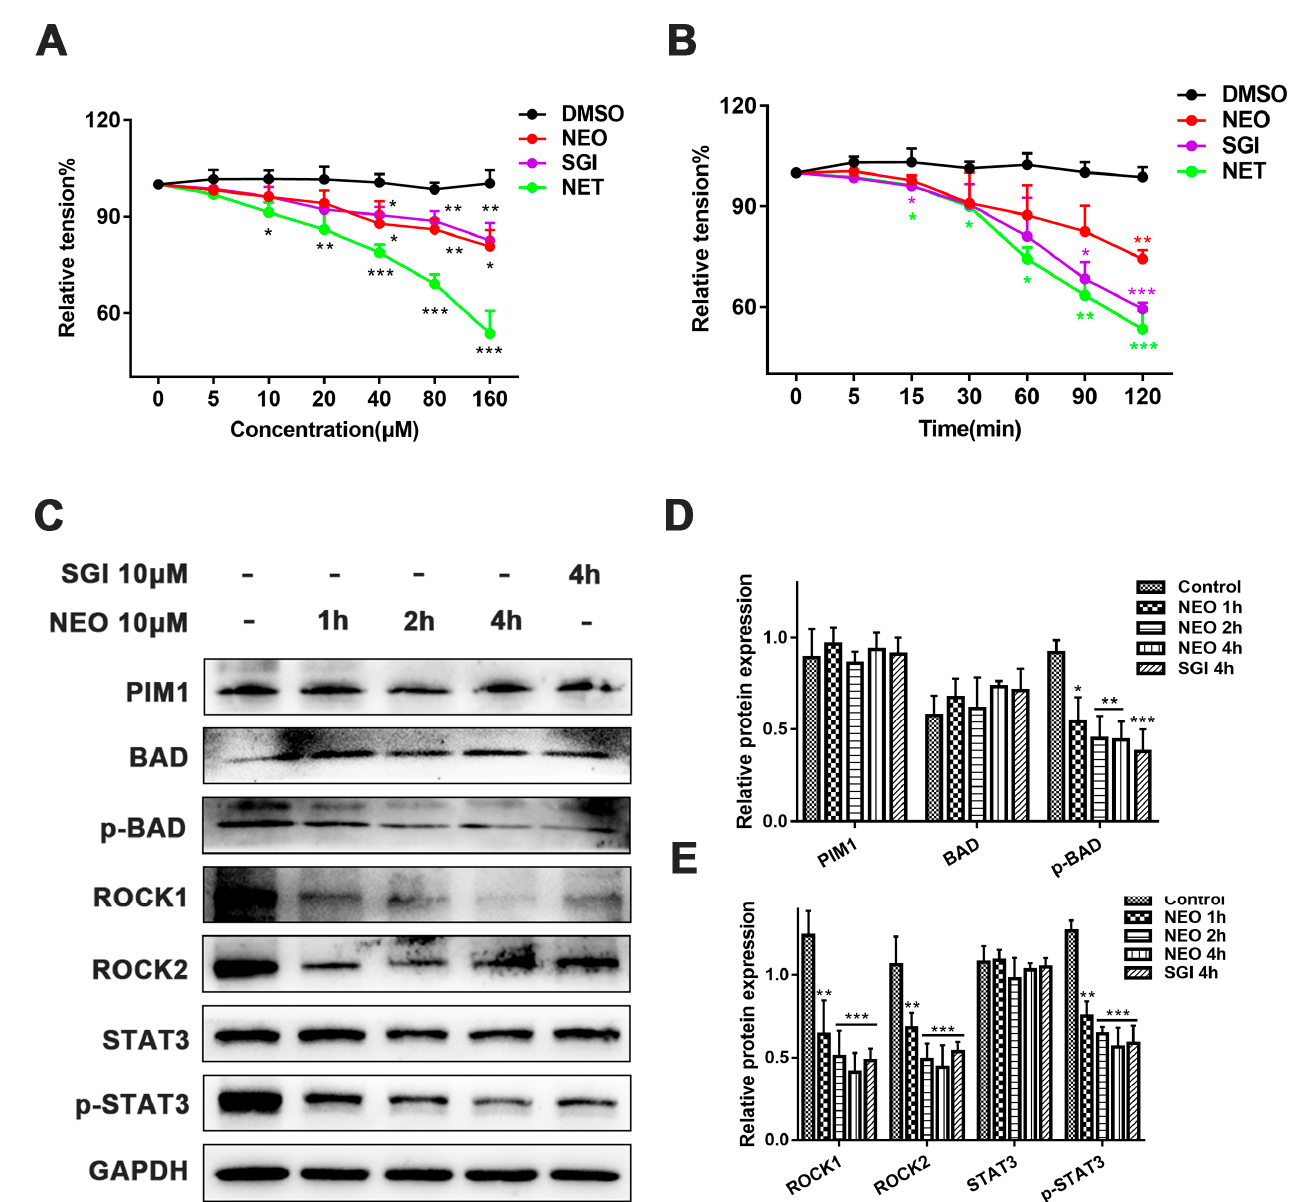
Figure 8. NEO, SGI-1776 and NET decreased IOP and dilated the smooth muscles. ( A ) Vasorelaxant effects of NEO, SGI-1776 and NET (concentration-dependent manner) on rat thoracic aorta rings precontracted with 60 mM KCL. ( B ) Vasorelaxant effects of NEO, SGI-1776 and NET (10 µ M; time- dependent manner) on rat thoracic aorta rings precontracted with 60 mM KCL. ( C ) Representative western blot image for PIM1 signaling in smooth muscles after exposure to 10 µ M NEO and SGI- 1776. ( D , E ) Optical density analysis chart of protein bands. The data shows that NEO and SGI-1776 significantly inhibited PIM1, ROCK1, ROCK2, p-BAD and p-STAT3 proteins. Each value is the mean ± SD for n = 3. * p < 0.05, ** p < 0.01, *** p < 0.001 versus the control